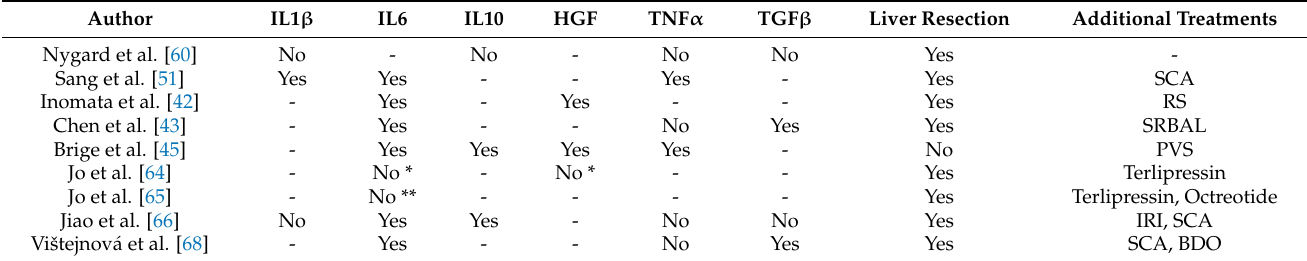
Table 4. Increasing in cytokine and chemokine values according to liver